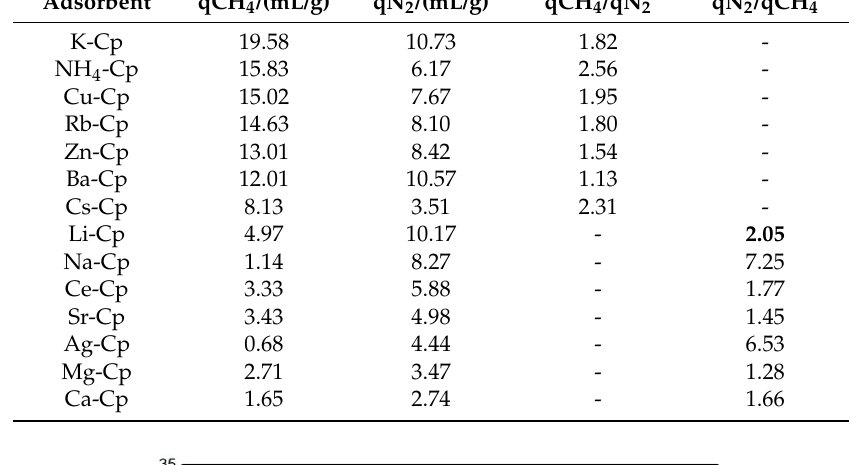
Figure 7. Low-pressure nitrogen ( a ) and methane ( b ) isotherms on modified Cp at 298 K. Figure 8. The Na-Cp and Ag-Cp breakthrough curve of nitrogen adsorption. Table 2. The adsorption capacity of clinoptilolite for CH 4 and N 2 (at a pressure of approximately 1.01 × 10 5 Pa at 298 K).